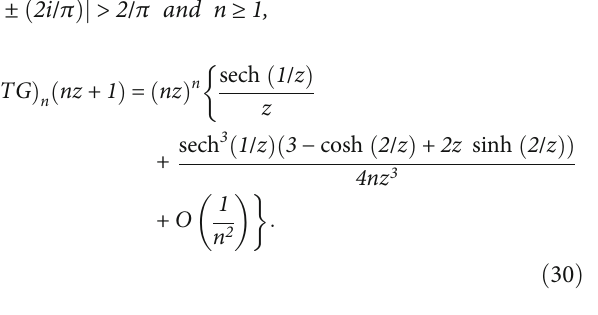
Figure 1: Solid lines represent T normalized by the factor ð 1 + j x / α j n Þ